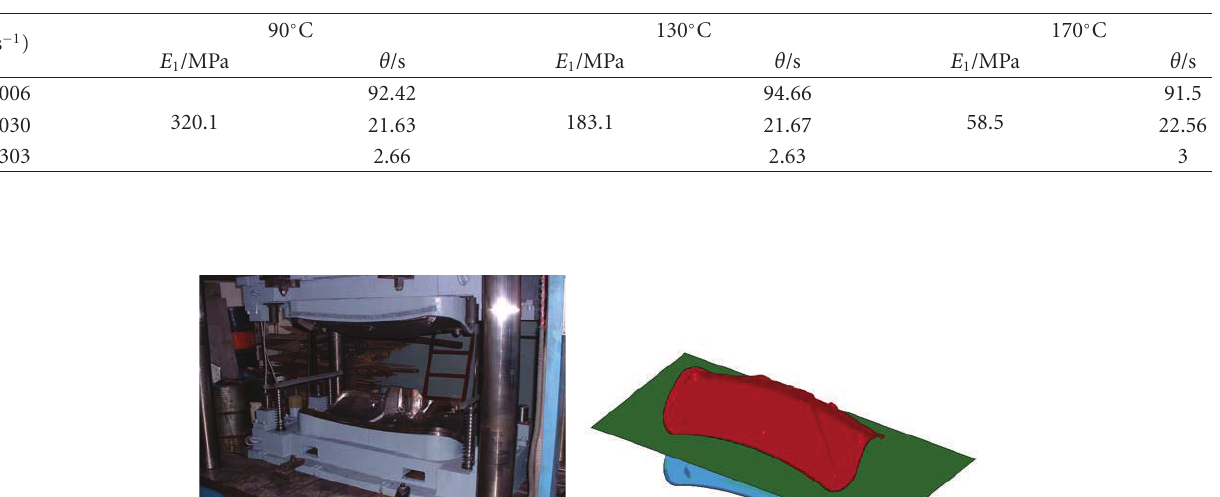
Table 1: Viscoelastic parameters of PP wood composites under di ff erent temperature.